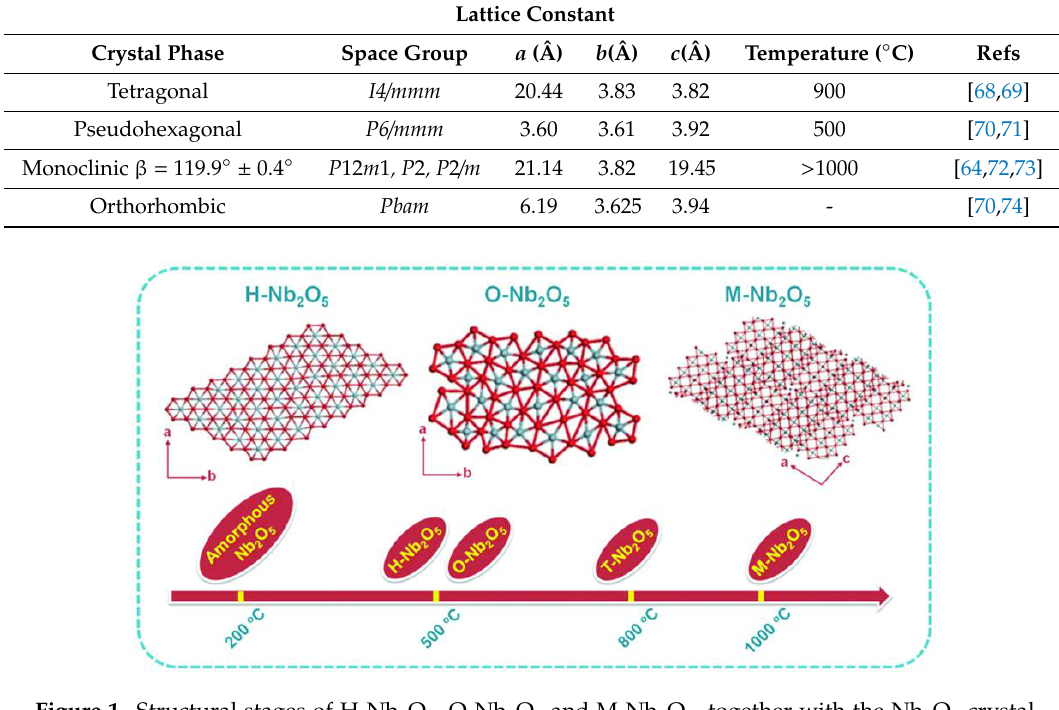
Table 1. Lattice parameters of TT, T, M and H phases of niobium oxide (Nb 2 O 5 ) modified from [63].